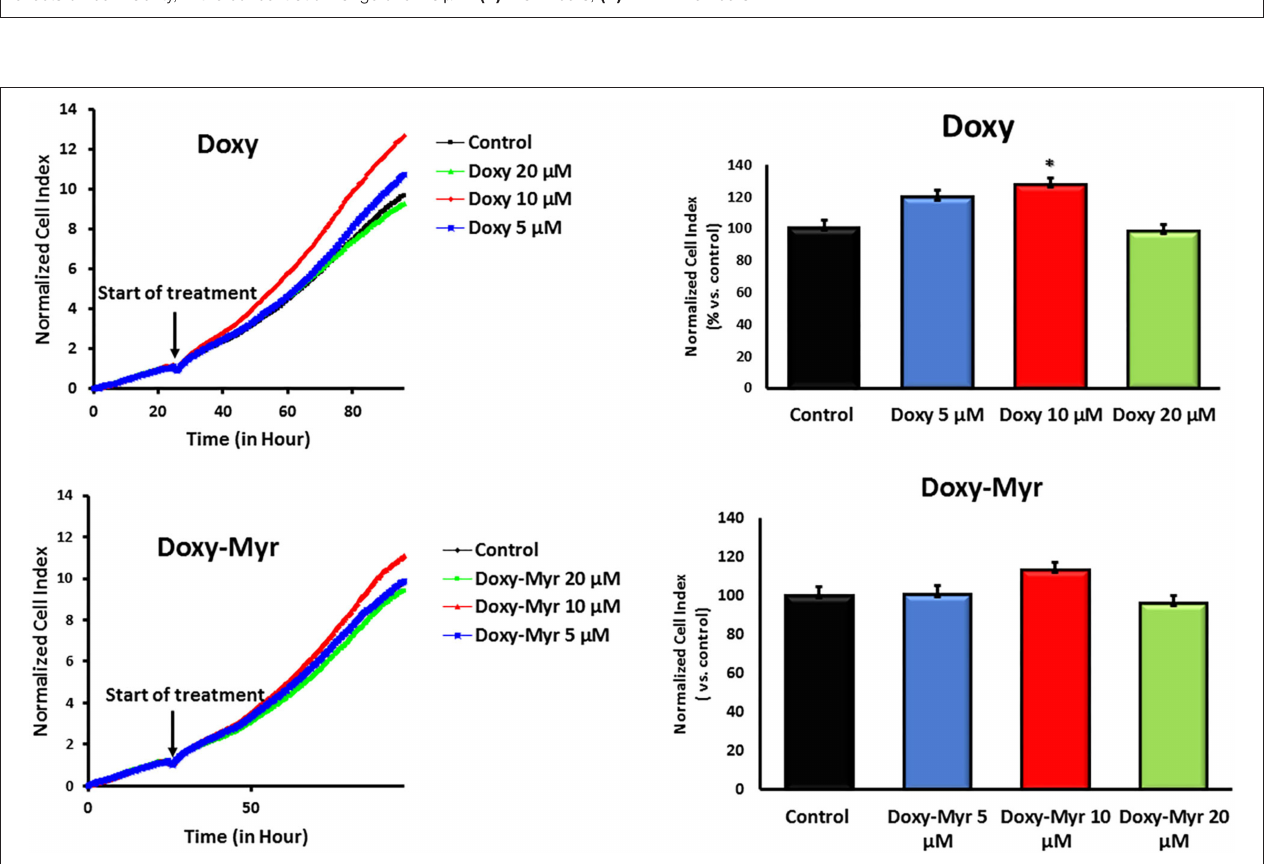
FIGURE 4 | Doxy-Myr does not affect the viability of MCF7 cells or normal fibroblasts, when grown as 2D-monolayers. To determine the effects of Doxy-Myr on cell viability, we next treated MCF7 cells and normal human fibroblasts (hTERT-BJ1) over a period of 3 days. Note that Doxycycline and Doxy-Myr had no appreciable effects on cell viability, in the concentration range of 5–20 µ M. (A) MCF7 cells, (B) hTERT-BJ1 cells.